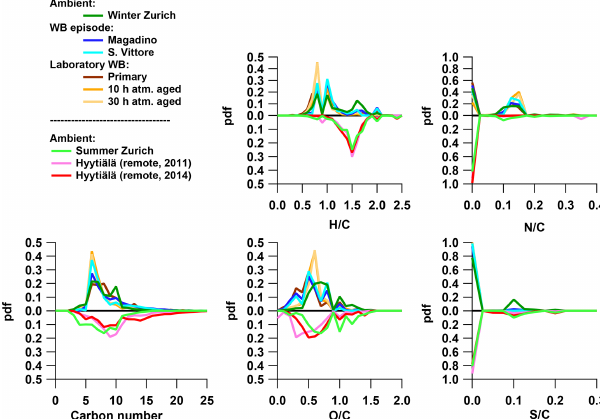
Figure 4. The probability density function (pdf) of bulk properties of organic aerosol (neutral composition based on (-)ESI-ultra-high- resolution mass spectra) for different emission and aging condi- tions: the number of carbon (H / C, O : C, N / C, and S / C) of ambient samples from Zurich in winter and summer, wood-burning episodes at the Alpine valley sites Magadino and San Vittore, and laboratory wood-burning experiments (fresh emissions and after simulated at- mospheric aging of 10 and 30h), as well as from boreal forest in Hyytiälä, Finland (Kourtchev et al., 2014a, 2016). The carbon num- ber is binned in ranges of rounded masses: H / C and O : C in ranges of 0.1 and N / C and S / C in ranges of